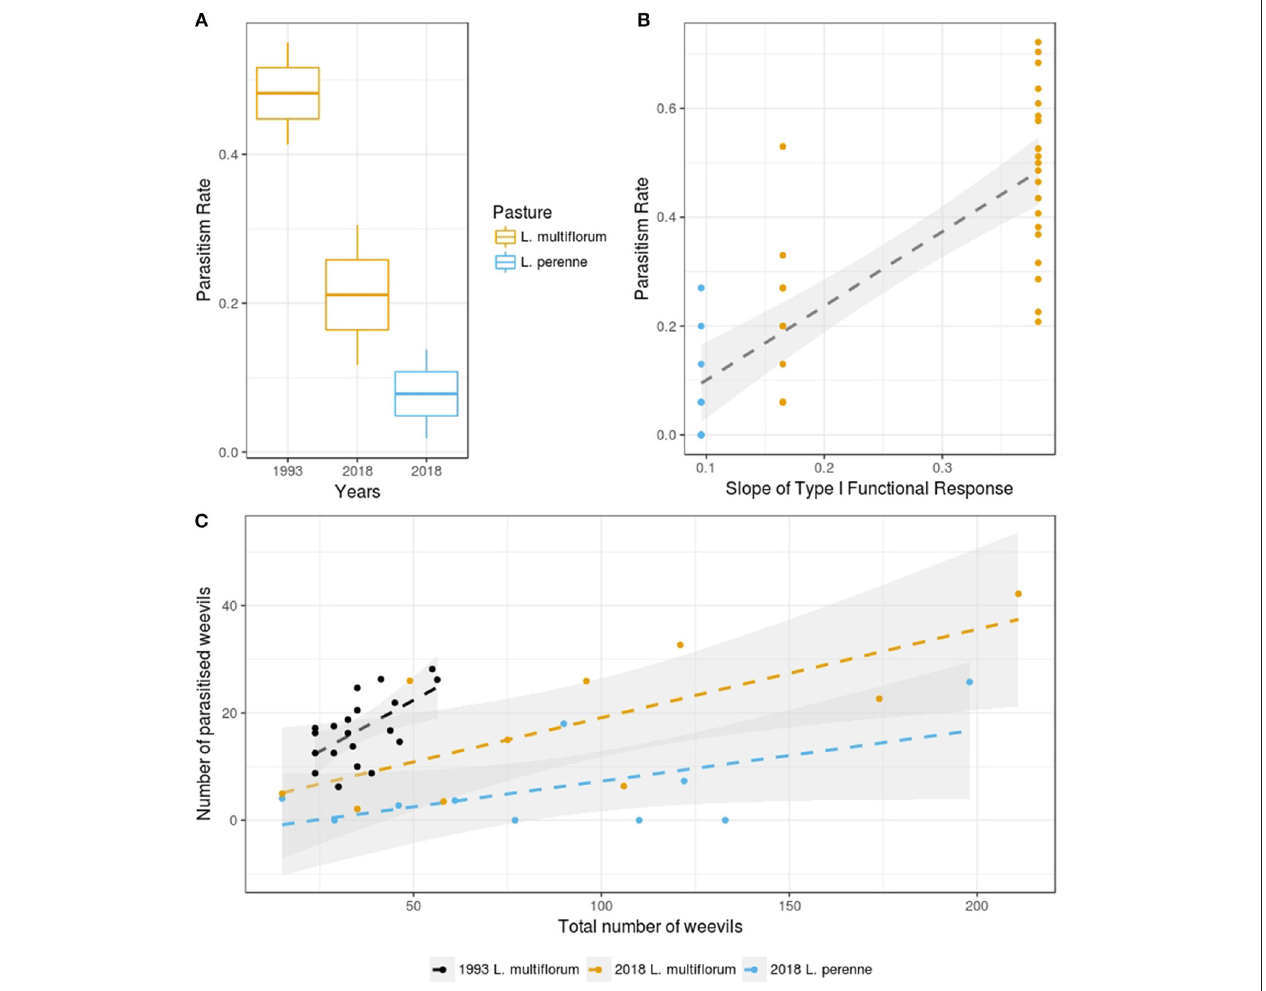
FIGURE 1 | (A) Parasitism rates for the different years and the different pastures of the current experiment. The boxes show the mean and standard error of the data, and the whiskers show the standard deviation of the data (yellow colors indicate Lolium multiflorum and blue colors indicate L. perenne ). (B) Relationship between the slope of the Type I functional response and parasitism rates for the combined historical and current data (i.e., 1993 and 2018 data). The 95% confidence intervals are based on bootstrapped model fitting (yellow dots indicate Lolium multiflorum and blue dots indicate L. perenne ). (C) Relationship between recovered weevil density and number of weevils parasitized (black dots indicate 1993 data in L. multiflorum , yellow dots indicate current data in L. multiflorum and blue dots indicate current data in L. perenne ). The 95% confidence intervals are based on bootstrapped model fitting.